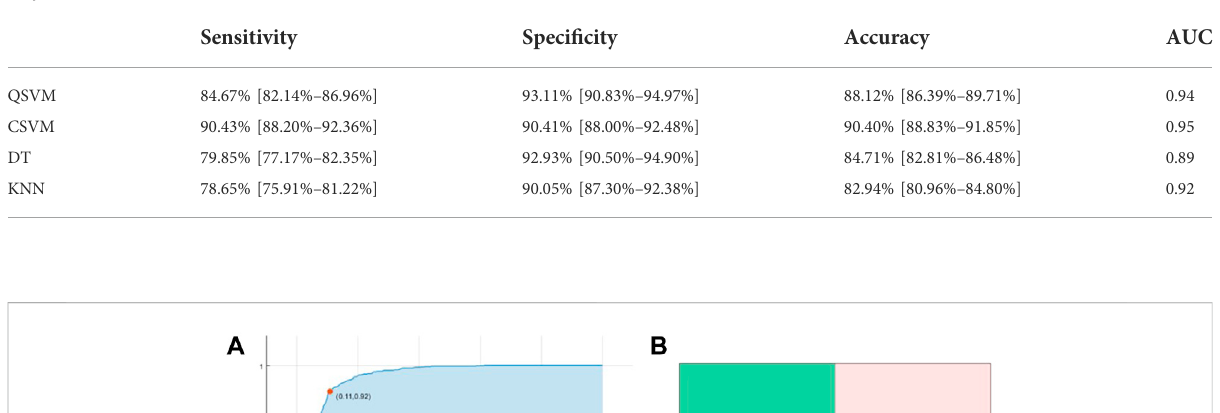
TABLE 4 Evaluation metrics for the different AI algorithms trained including sensitivity, speci fi city and accuracy expressed in percentage and respective con fi dence interval in brackets, and Area Under the Curve (AUC).